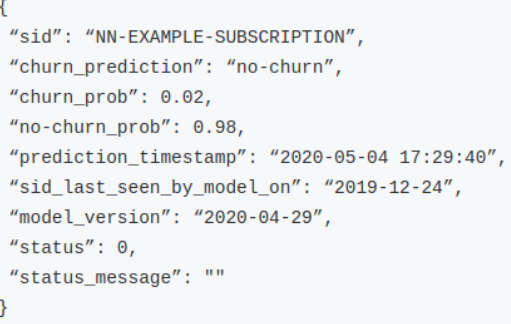
Figure 5. CSCP prediction answer